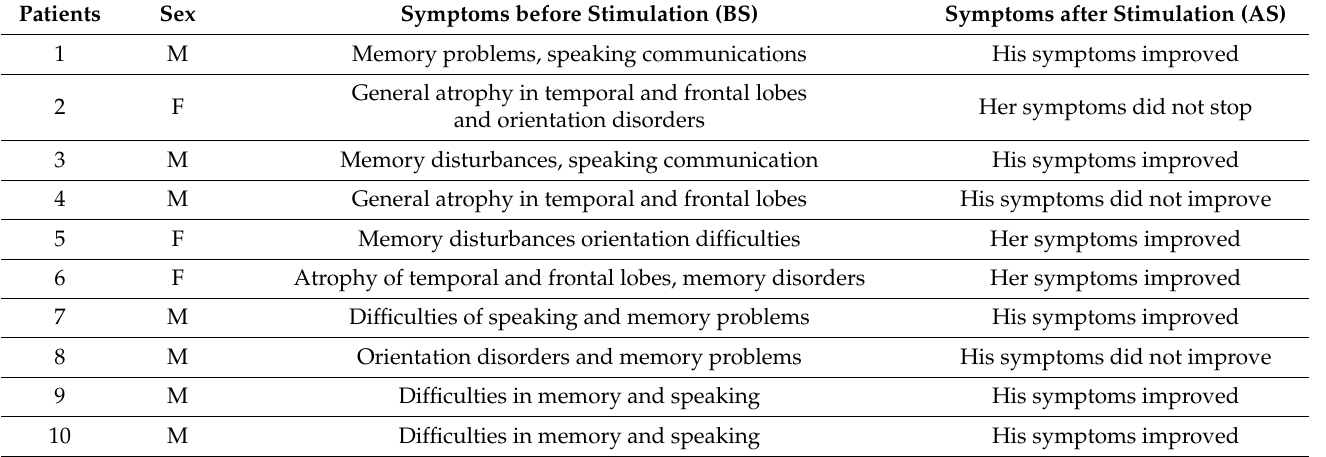
Table 4. Clinical symptomatology of the Alzheimer patients as it was assessed by neurologists before and after stimulations (2nd and 3rd day in the lab) (F: Female; M: